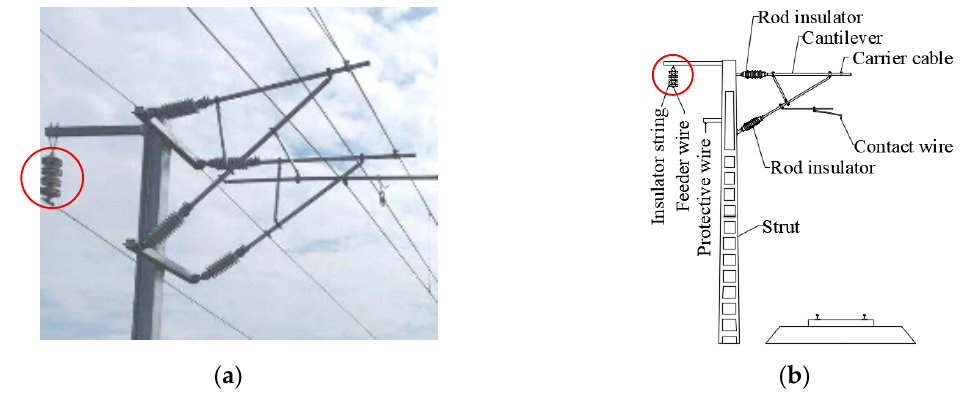
Figure2. Insulatorstringofelectrifiedrailwaycatenary: ( a )insulatorstringinworkingstate; ( b )catenary Figure 2. Insulator string of electrified railway catenary: ( a ) insulator string in working state; ( b ) structure chart. catenary structure chart.